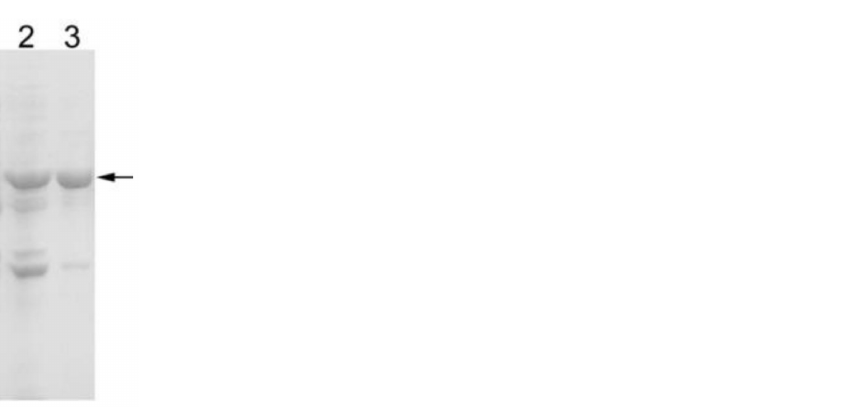
Figure 1. Purification of outer membrane protein A (OmpA). M, protein marker; 1, non-induced strain; 2, Isopropyl- β - D -thiogalactoside (IPTG)-induced strain; 3, purified OmpA.